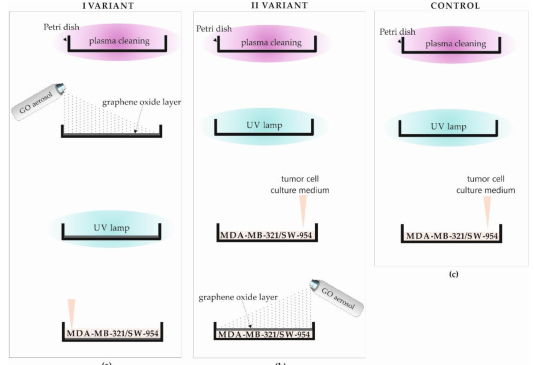
Figure 1. Scheme of preparation of Petri dishes for cancer cell culture in: ( a ) I VARIANT—Petri dish plasma cleaning, GO deposition, sterilization of the Petri dish surface with a UV lamp, and cells culturing; ( b ) II VARIANT—Petri dish plasma cleaning, sterilization of the Petri dish surface with a UV lamp, cell culturing, and GO deposition; ( c ) CONTROL—Petri dish plasma cleaning, sterilization of the Petri dish surface with UV lamp, and cells